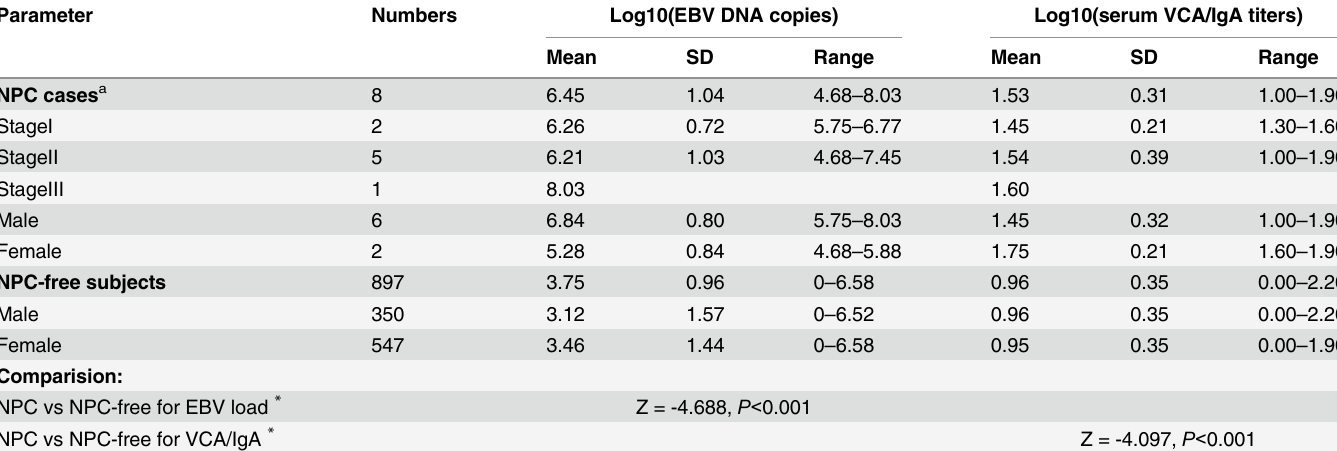
Table 5. Comparison of viral load and VCA/IgA titers between NPC and NPC-free high-risk subjects.